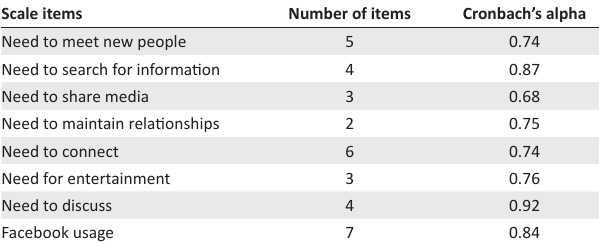
TABLE 1: Reliability and validity of measurement scales.